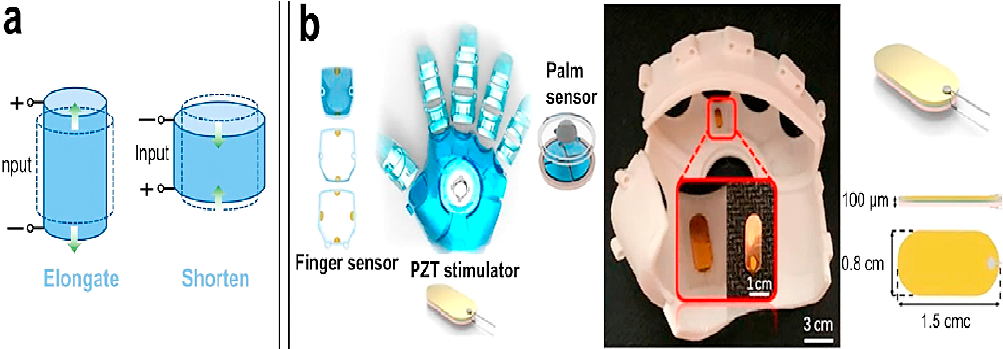
Figure 5. Examples of interfaces with piezoelectric actuators for generating haptic feedback. Illustration of the piezoelectric haptic feedback system ( a ). To give rapid feedback on the contraction and release of haptic sensations, a smart glove incorporates sensors and PZT stimulators ( b ) [34].